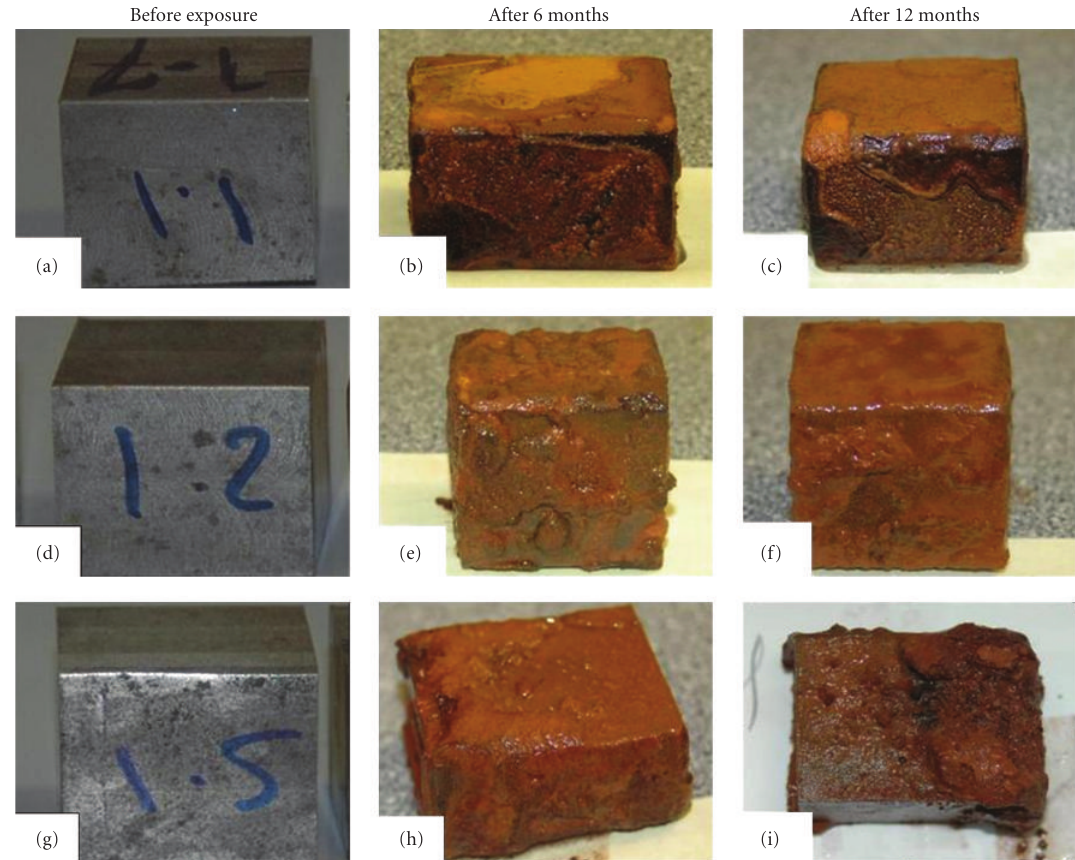
Figure 4: Change in the type and state of the corrosion